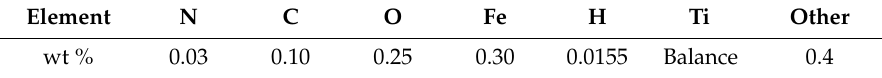
Table 1. Chemical composition (wt %) of titanium c.p. grade 2